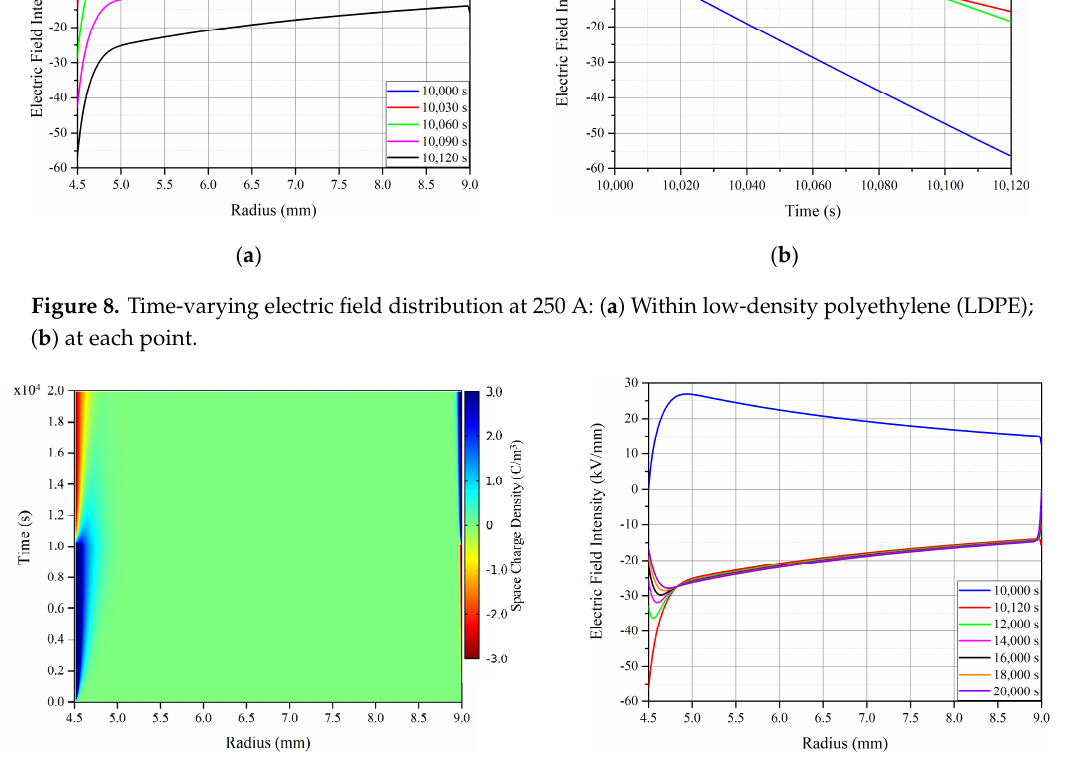
Figure 9. Simulation results after polarity reversal at 250 A: ( a ) Space charge density within LDPE (C / m 3 ); ( b ) time-varying electric field distribution.